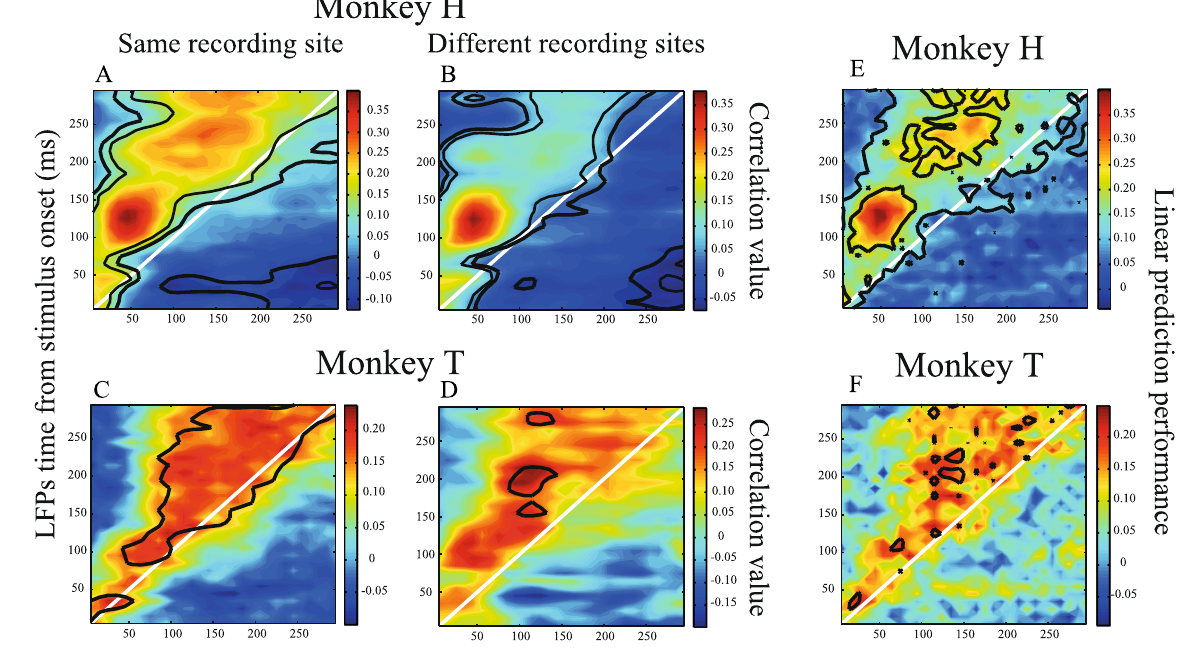
Figure 4. Correlation maps for spiking activity/LFP from same/different recording sites and linear model prediction of LFPs. ( A , C ) Similar correlation maps as in Fig. 3A,B where spiking activity and LFP come from the same recording site. ( B , D ) Correlation maps based on spiking activity and LFP recorded from different MT sites simultaneously. Top and bottom panels correspond to monkeys H and T, respectively. ( E , F ) Linear model predictions of LFPs based on spiking activity. Performance of estimating LFPs based on spiking activity for different pairs of intervals relative to stimulus onset is shown. Colors code the correlation of a linear estimator’s output with original LFPs at each spike-LFP time pair, and each panel reflects the results for one monkey. The diagonal white line in each panel indicates simultaneous spike-LFP pairs. Black borders specify time pairs with statistically significant estimation performances across recording sites, quantified as the correlation between the estimated and original LFP amplitudes (p < 0.05, t-test, corrected for multiple